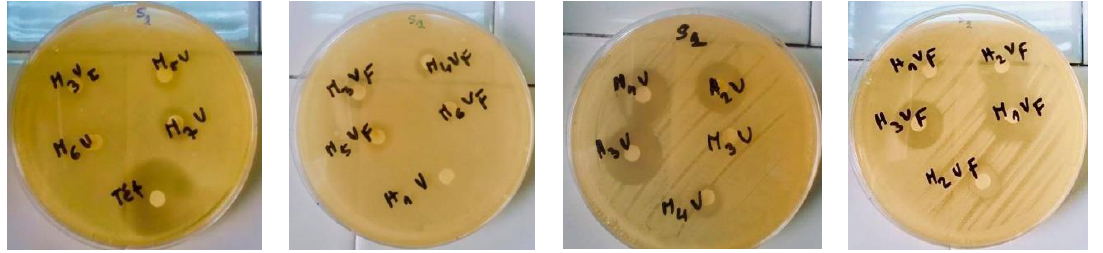
Figure 7. Antimicrobial activity of some samples determined via the inhibition zone (mm) around discs impregnated with 5a (M1V), 5b (M2V), 5c (M3V), 5d (M4V), 5e (M7V), 5f (H1V), 5g (H2V), 5h (H3V), 5i (M1VF), 5j (M2VF), 5k (M3VF), 5l (M4VF), 5m (M7VF), 5n (H1VF), 5o (H2VF), 5p (H3VF), and 5q (M3VI) compounds (10 mg/disk); Tetracycline (10 mg/mL) or Amphotericin B (10 mg/mL) expressed as mean ± SD (n = 3).